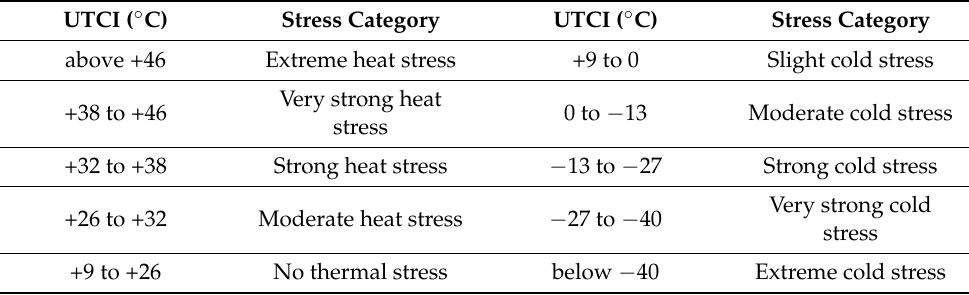
Table 1. Scale of assessment of heat stress of the organism according to the UTCI index [24].